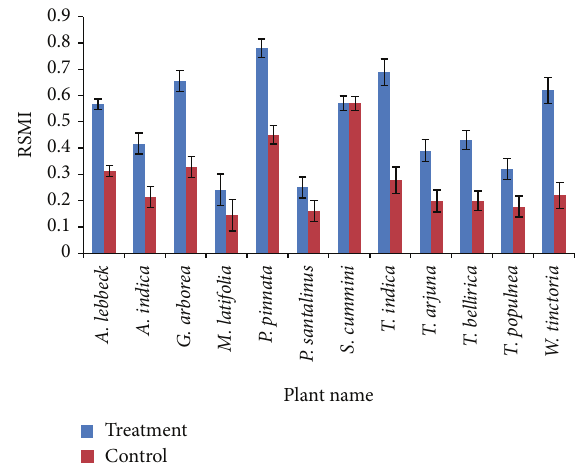
Figure 3: RSMI values for the different tree species in the